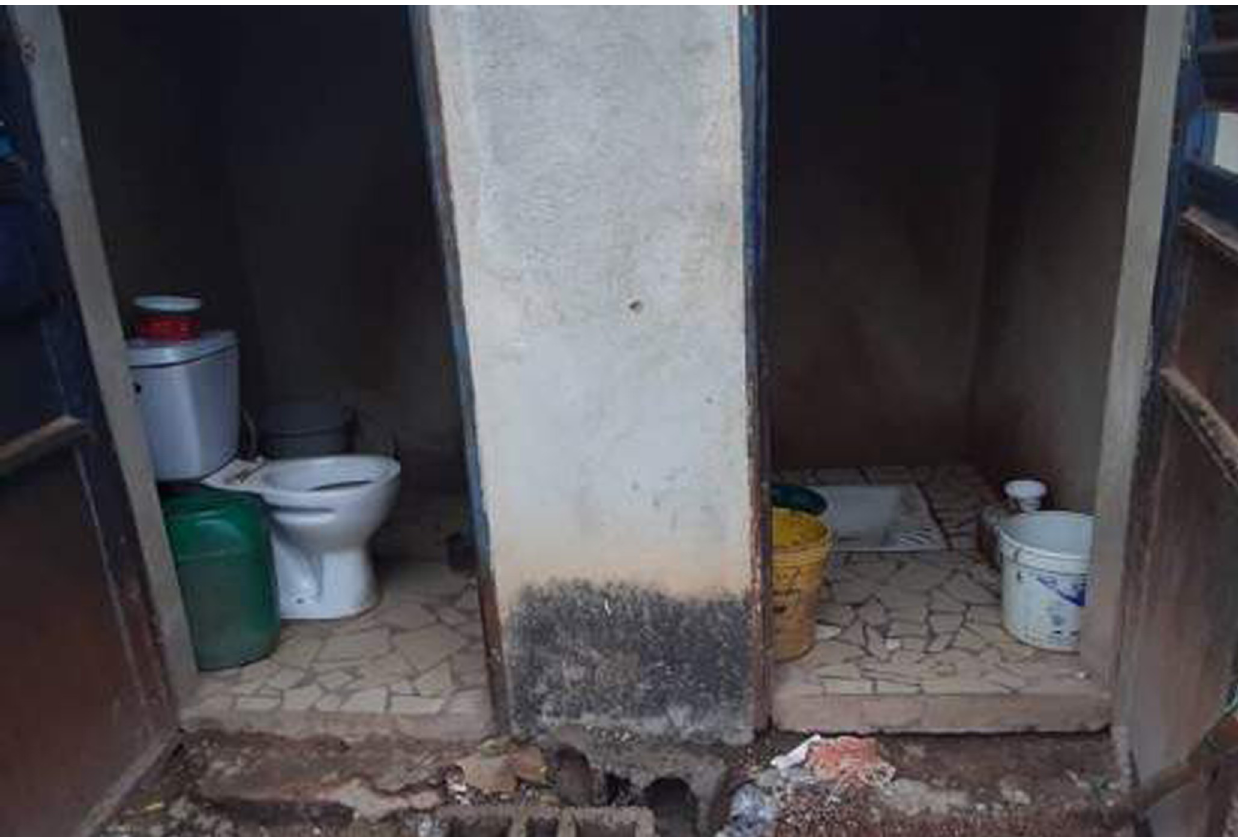
Fig 4. Picture of a toilet facility in Diourbel